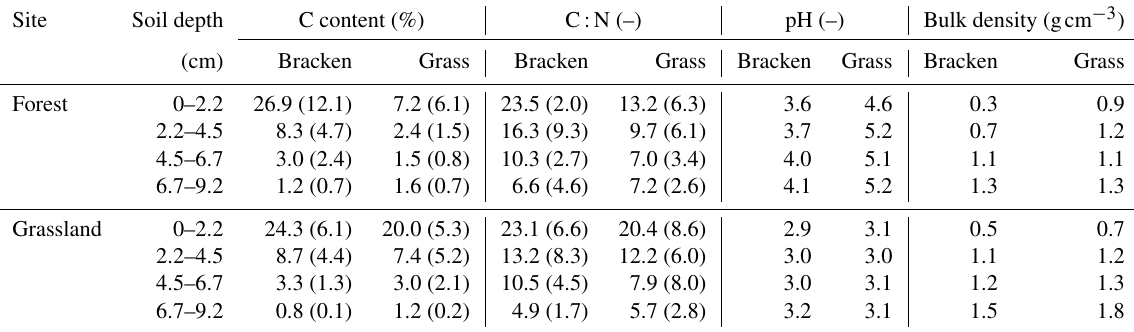
Table 1. Selected properties of soil samples ( n = 12) retrieved from the CO 2 efflux monitoring collars after the field campaign had been completed. Presented values represent the mean ( n = 6) with SD in the brackets. Site Soil depth C content (%) C:N (–) Bulk density (gcm − 3 ) (cm) Bracken Grass Bracken Grass Bracken Grass Bracken Grass Forest 0–2.2